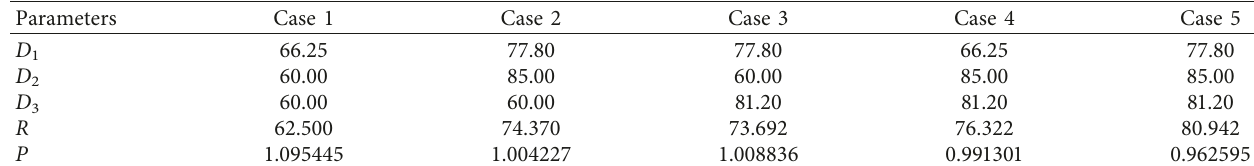
Table 5: Weighted evaluations of different cases.